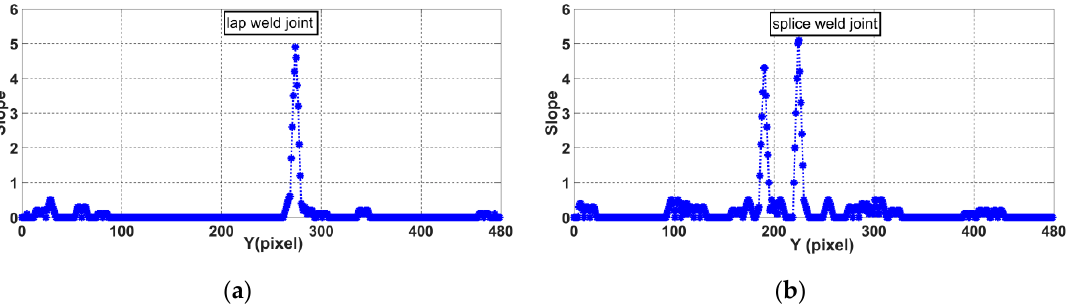
Figure 9. Slope distribution along the laser curve: ( a ) lap weld joint and ( b ) splice weld joint.